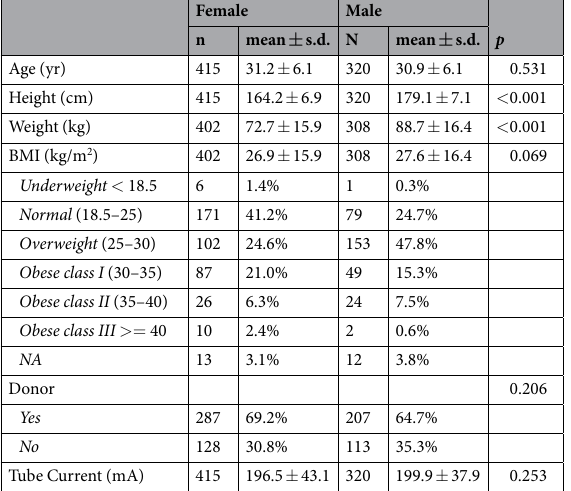
Table 1. Cohort demographics and CT parameters split by sex. Donor proportion p-value from Chi-squared test, all others from